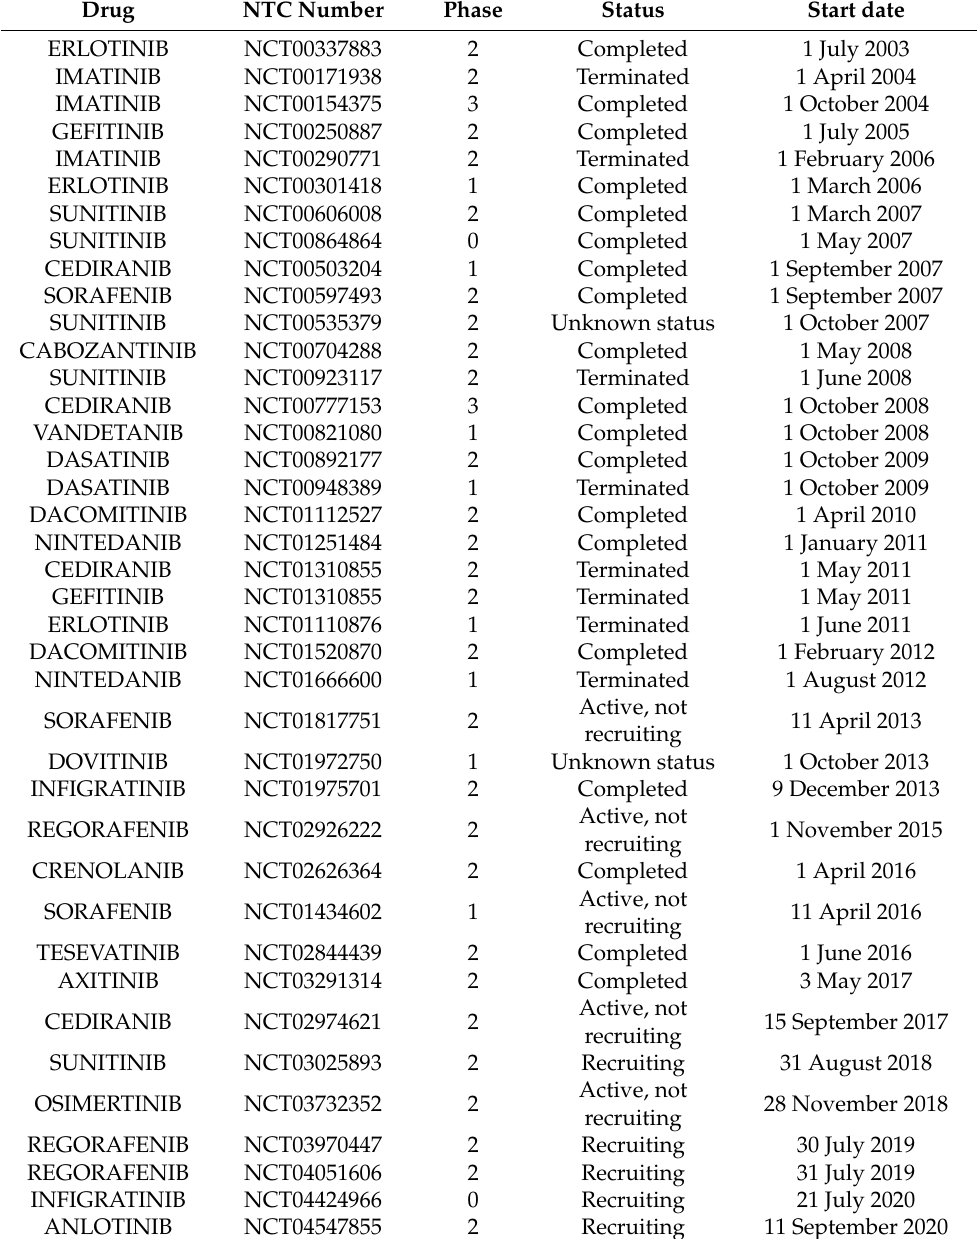
Table 3. Clinical trials of receptor tyrosine kinase inhibitors in recurrent or progressive